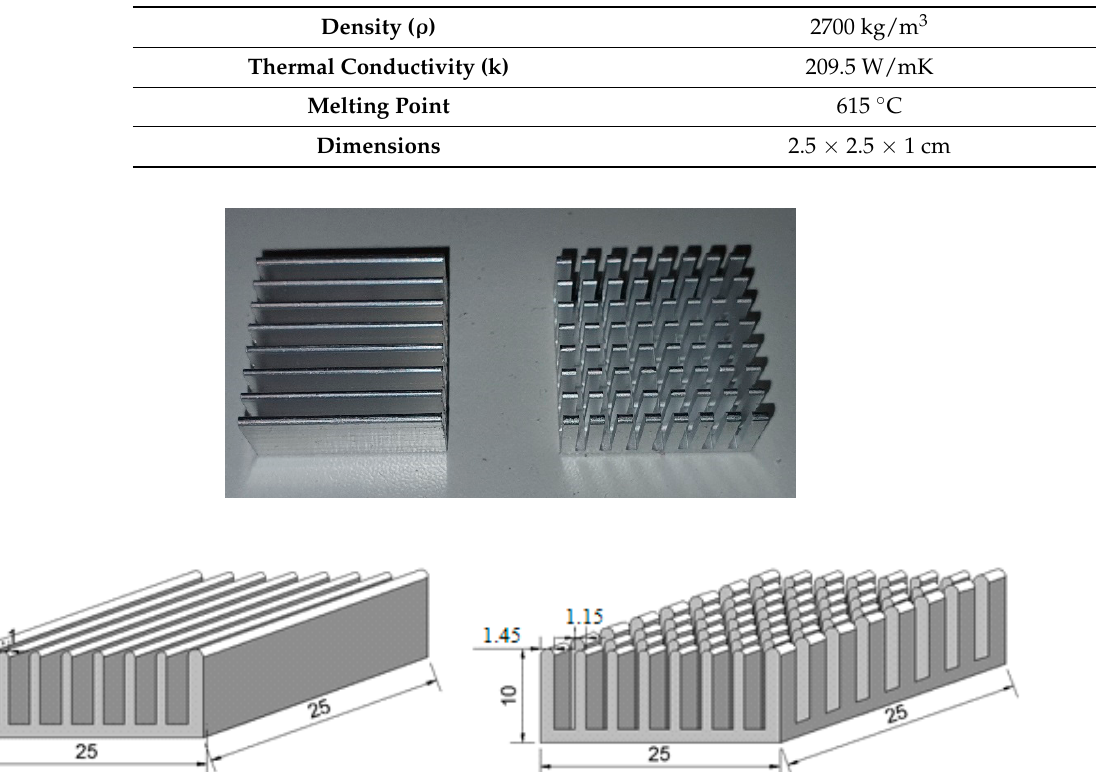
Table 1. Material properties of the Aluminum heat sinks.